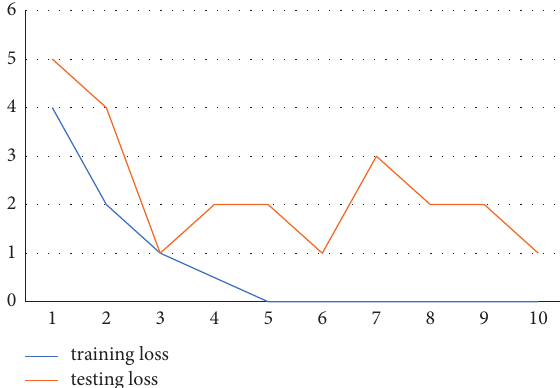
Figure 12: The convergence loss function history of the 16 × 16